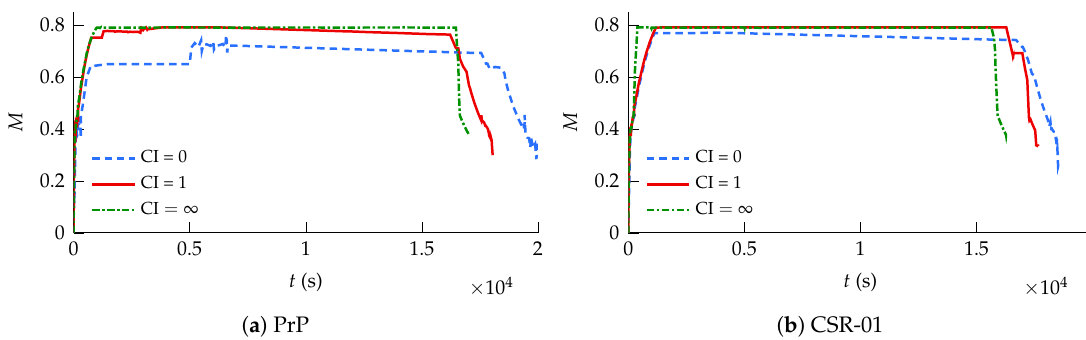
Figure 9. Design mission Mach number for the ( a ) PrP and ( b ) CSR-01, for different CIs.